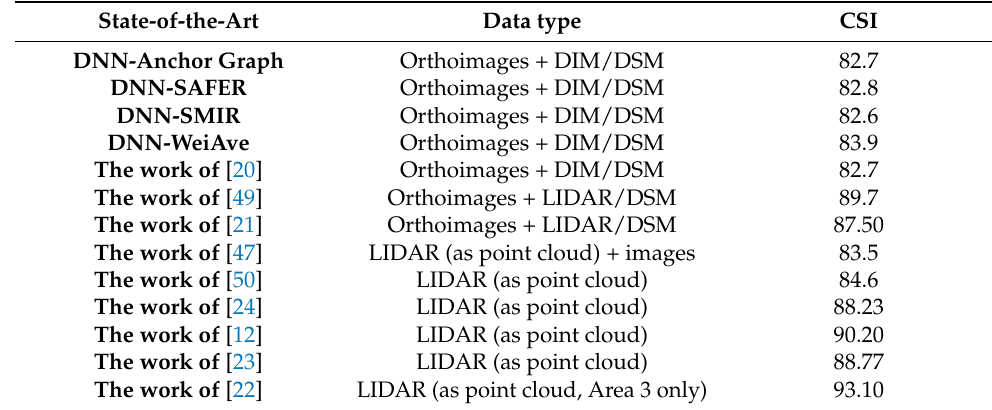
Table 8. Comparative results against other state-of-the-art techniques and different types of data for the same examined three